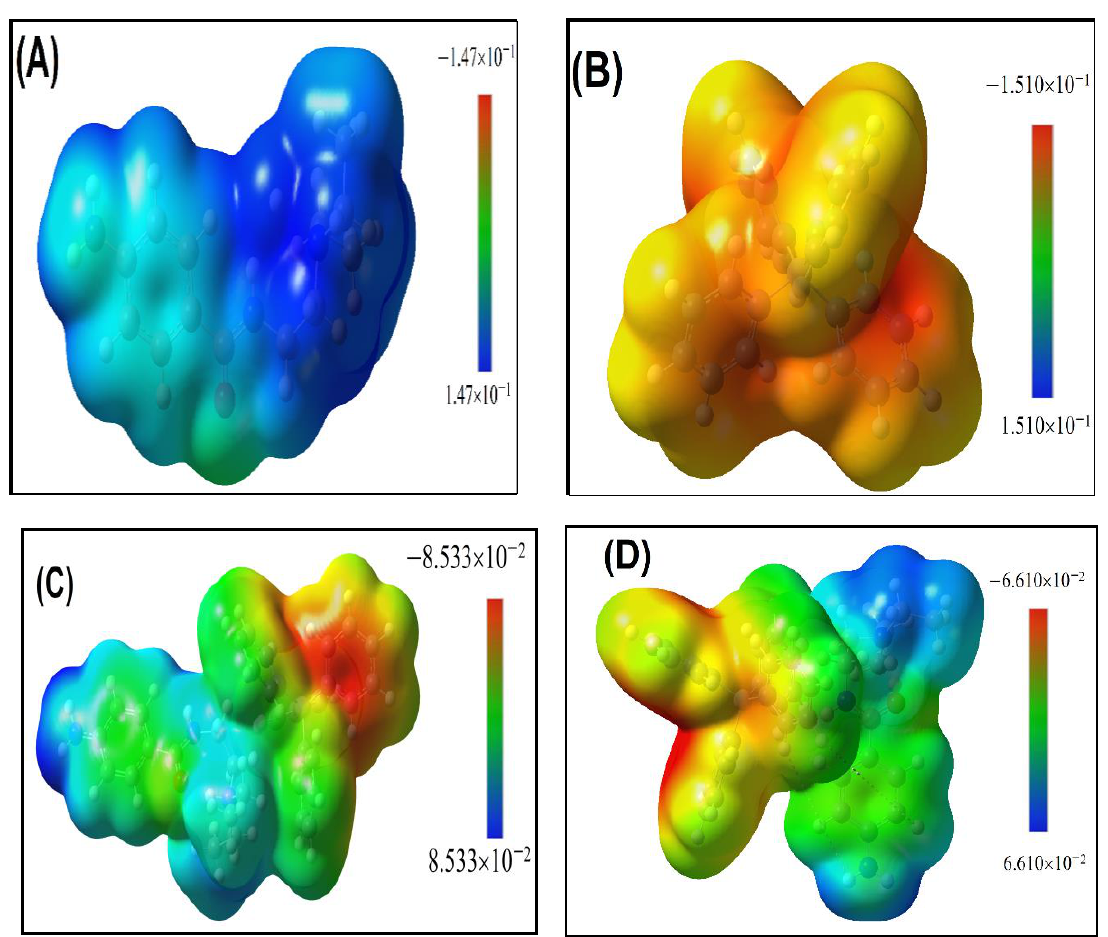
Figure 8. Electrophilic site study by MESP for: ( A ) procainamide cation, ( B ) tetraphenylborate anion, ( C ) S1 configuration, and ( D ) S1 configuration of complex of procainamide with tetraphenylborate, superimposed on the structure's isodensity surface (isovalue = 0.002), which was calculated at the B3LYP/6311 G (d, p) level.